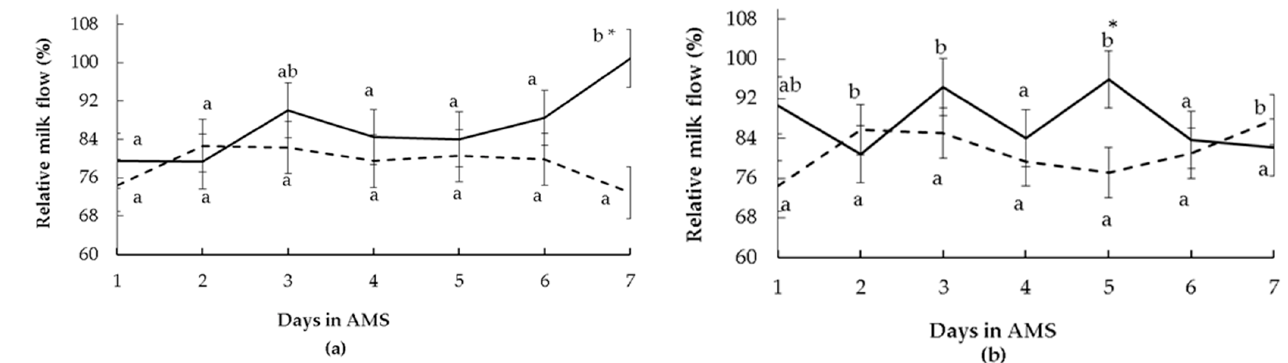
Figure 5. Milk flow (mean ± SE) expressed as relative values of the conventional milking system (CMS) results (100% = mean CMS yields of seven days prior to the system changeover) of multiparous Holstein cows during seven days after changeover from the CMS to the automatic milking system (AMS) according to ( a ) race time and ( b ) flight speed test at CMS (calm: curt line, reactive: solid line). Differences between days are indicated with different letters, and differences between temper-ament classes within the same days are indicated with * ( p ≤ 0.05).